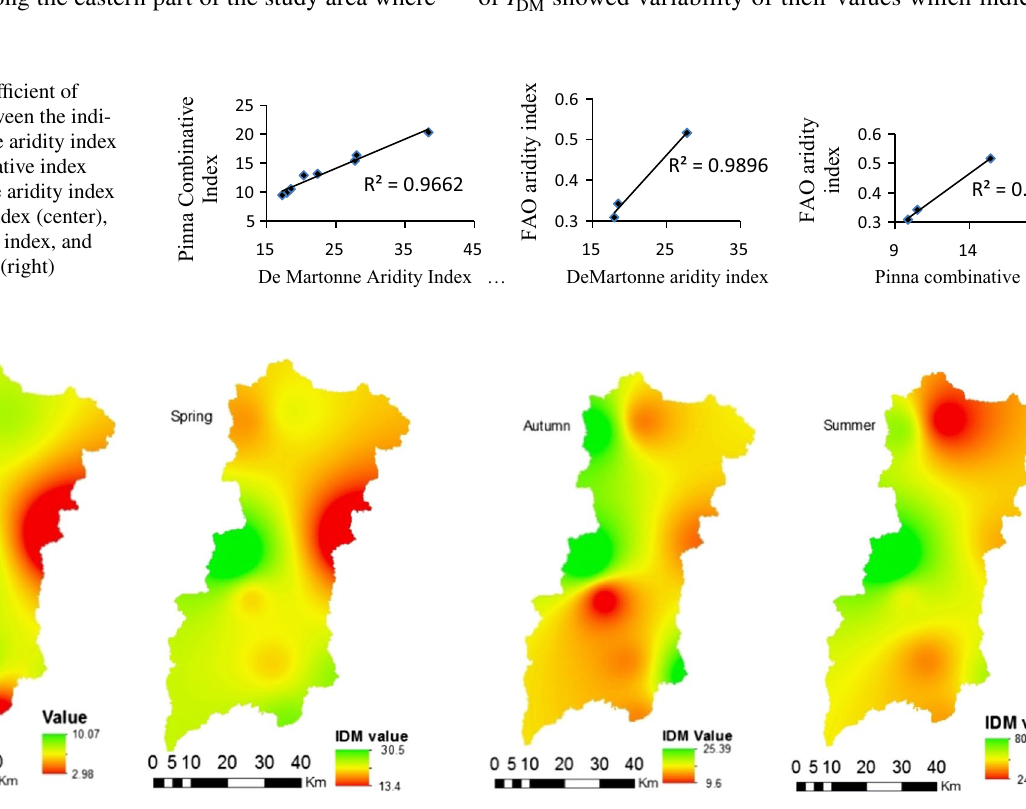
Fig. 3 Seasonal spatial distribution of the De Martonne aridity